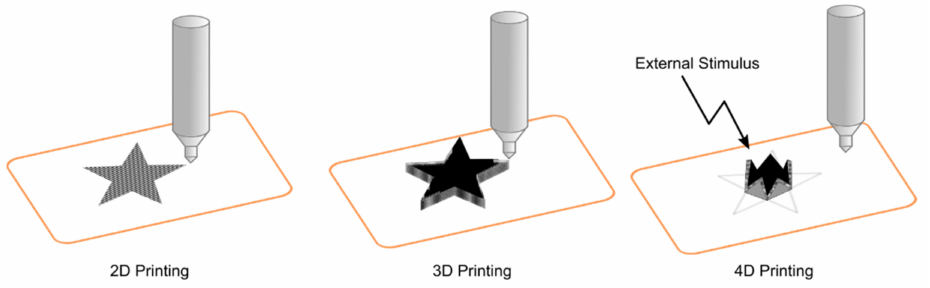
Figure 5. Differences between 2D, 3D, and 4D